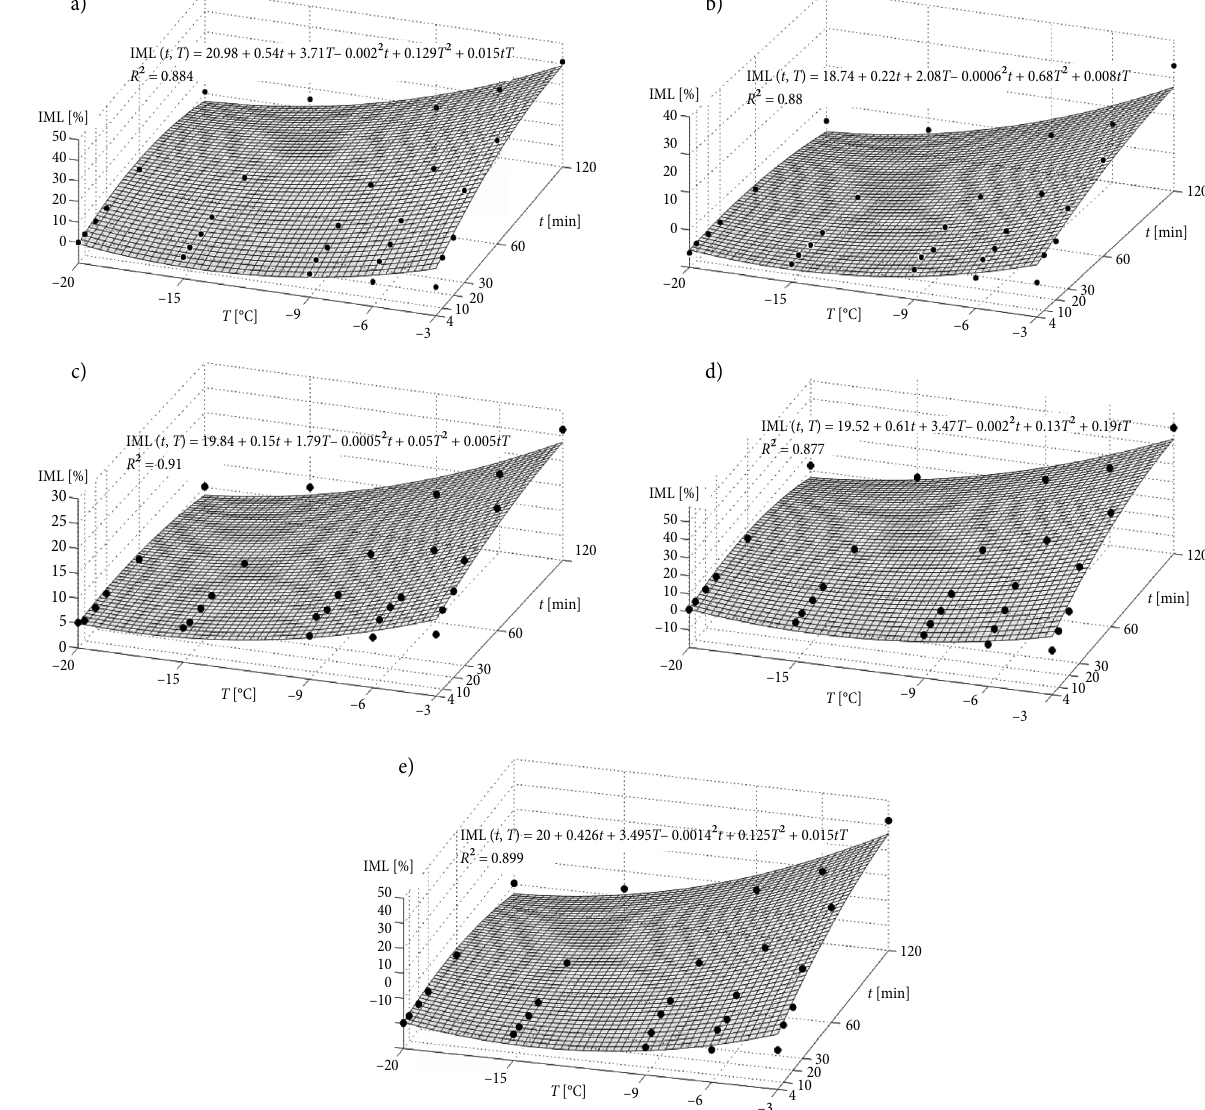
Fig. 5. Influence of temperature and duration of melting action on the IML, when DM is applied: a – NaCl; b – CaCl 2 ; c – MgCl 2 ; d – SCMC; e –